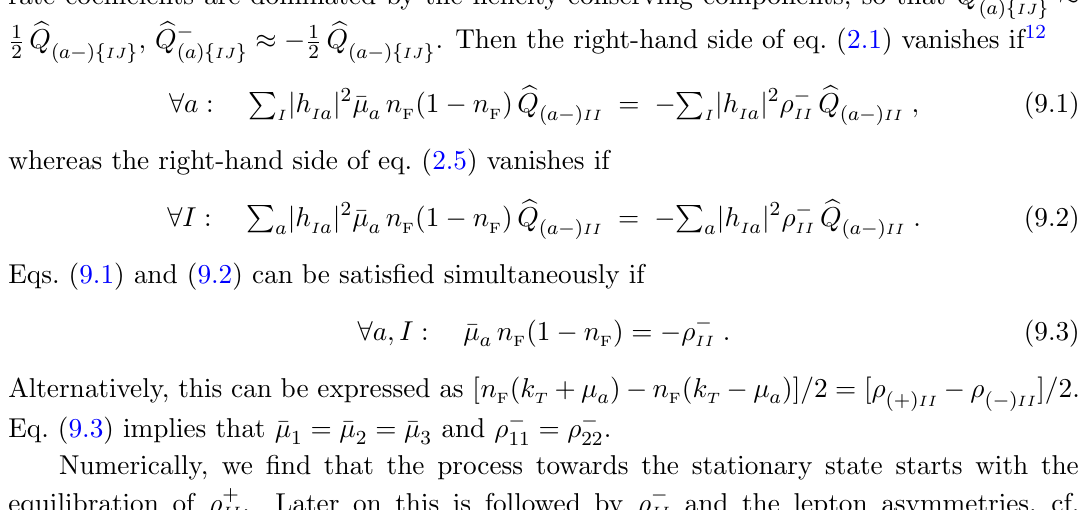
Figure 4 . Left: an illustration of the equilibration of the diagonal components of the density matrix. For the normalization of the helicity asymmetries, we have de(cid:12)ned (cid:22) (cid:22) momentum was chosen as k